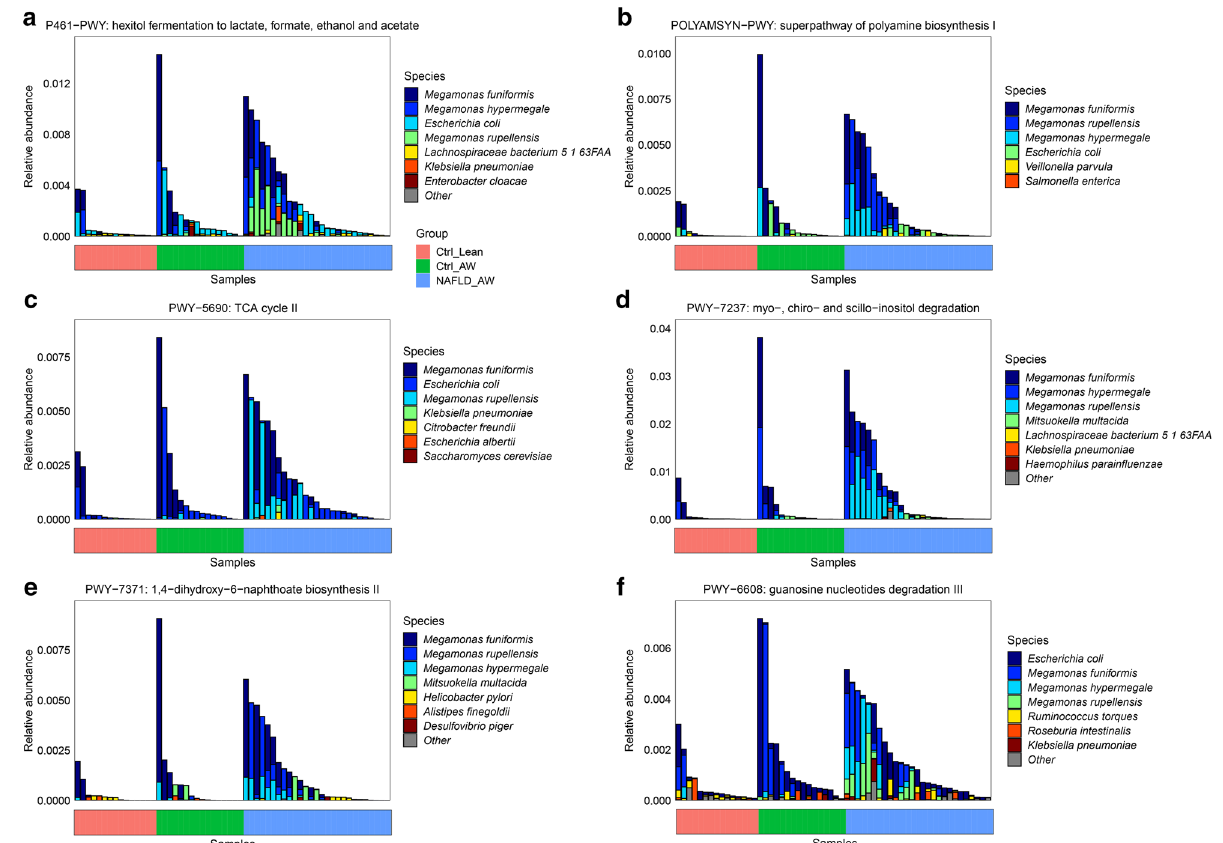
Figure 6. Comparison of the gut microbial pathways contributed by the genus Megamonas between the BMI- MRS 3 groups from the HUMAnN2 profiles. ( a ) The pathway of P461-PWY between those groups. ( b ) The pathway of POLYAMSYN-PWY between those groups. ( c ) The pathway of PWY-5690 between those groups. ( d ) The pathway of PWY-7237 between those groups. ( e ) The pathway of PWY-7371 between those groups. ( f ) The pathway of PWY-6608 between those groups. Compared with the Ctrl_Lean (healthy children), the pathways contributed by the genus Megamonas are significantly increased in the NAFLD-AW